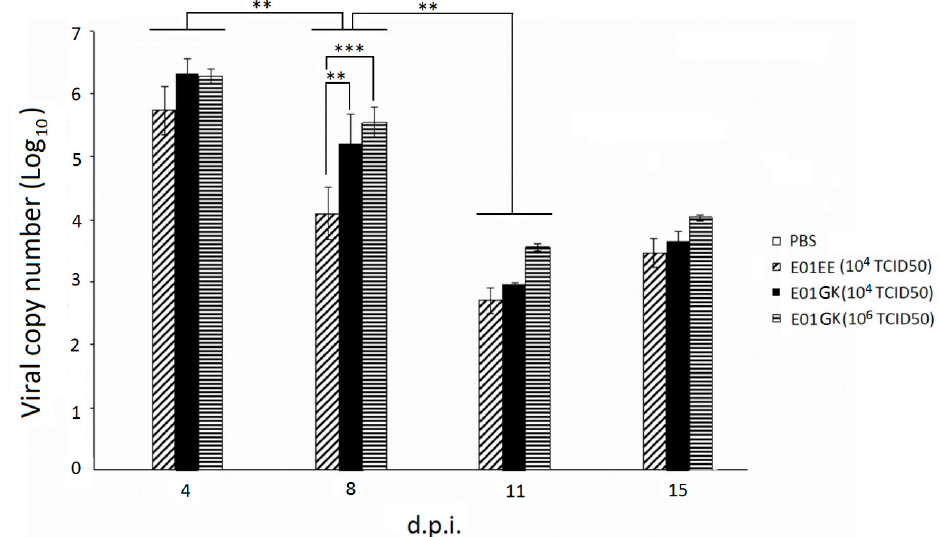
Figure 6. The virus quantification from swab and nasal wash samples using qRT-PCR. Mice were inoculated intranasally with 10 4 TCID 50 / mL of E01EE, 10 4 TCID 50 / mL of E01GK, 10 6 TCID 50 / mL of E01GK or PBS in a 50 µ L volume (25 µ L per nostril). No detectable signals were noted in the negative